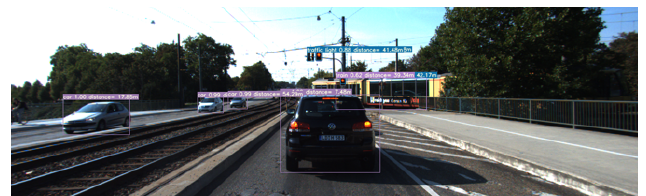
Figure 9. Object detection and localisation results over a sample from the KITTI